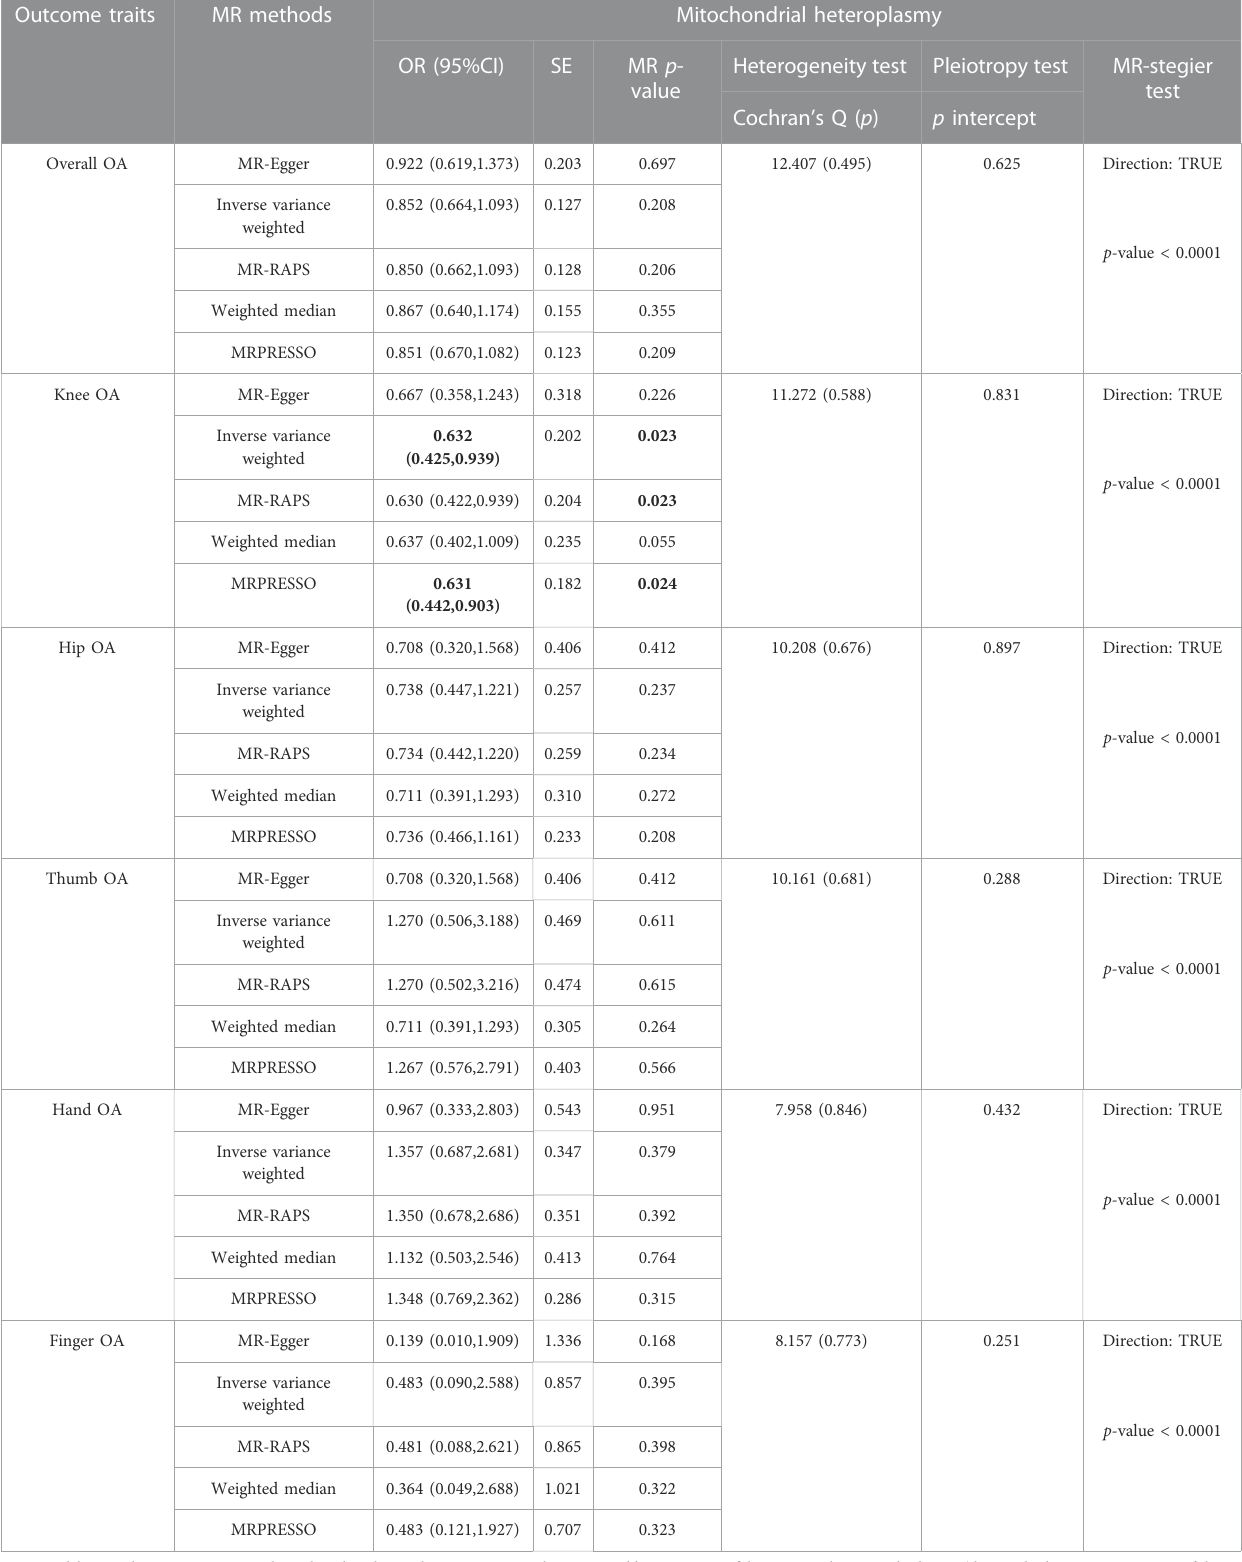
TABLE 1 MR results of causal effect of mitochondrial heteroplasmy on OA and its other phenotypes. Outcome